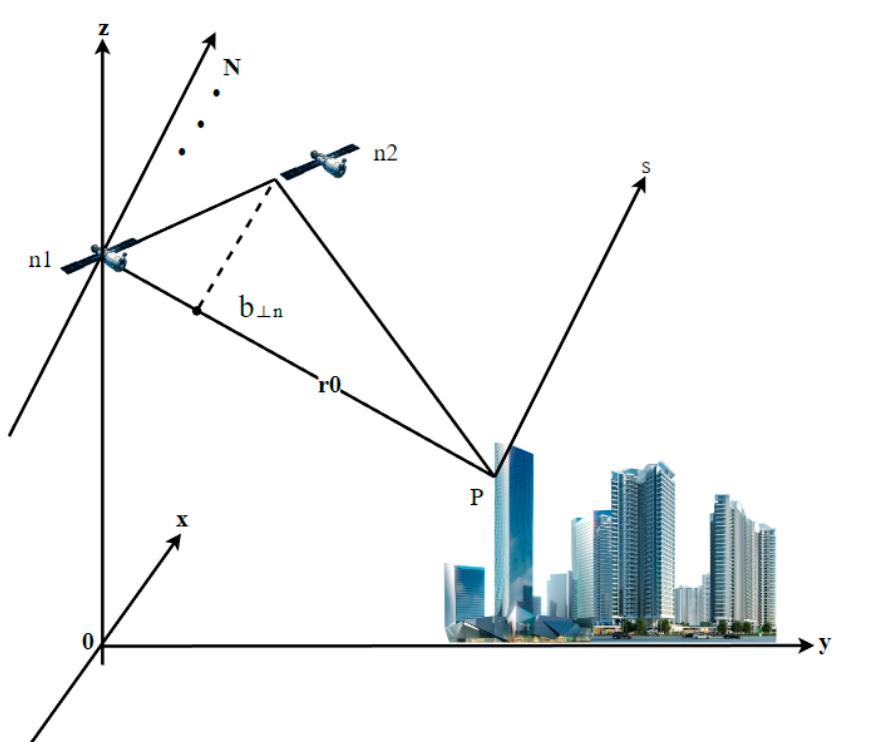
Figure 3. The imaging mode of TomoSAR.